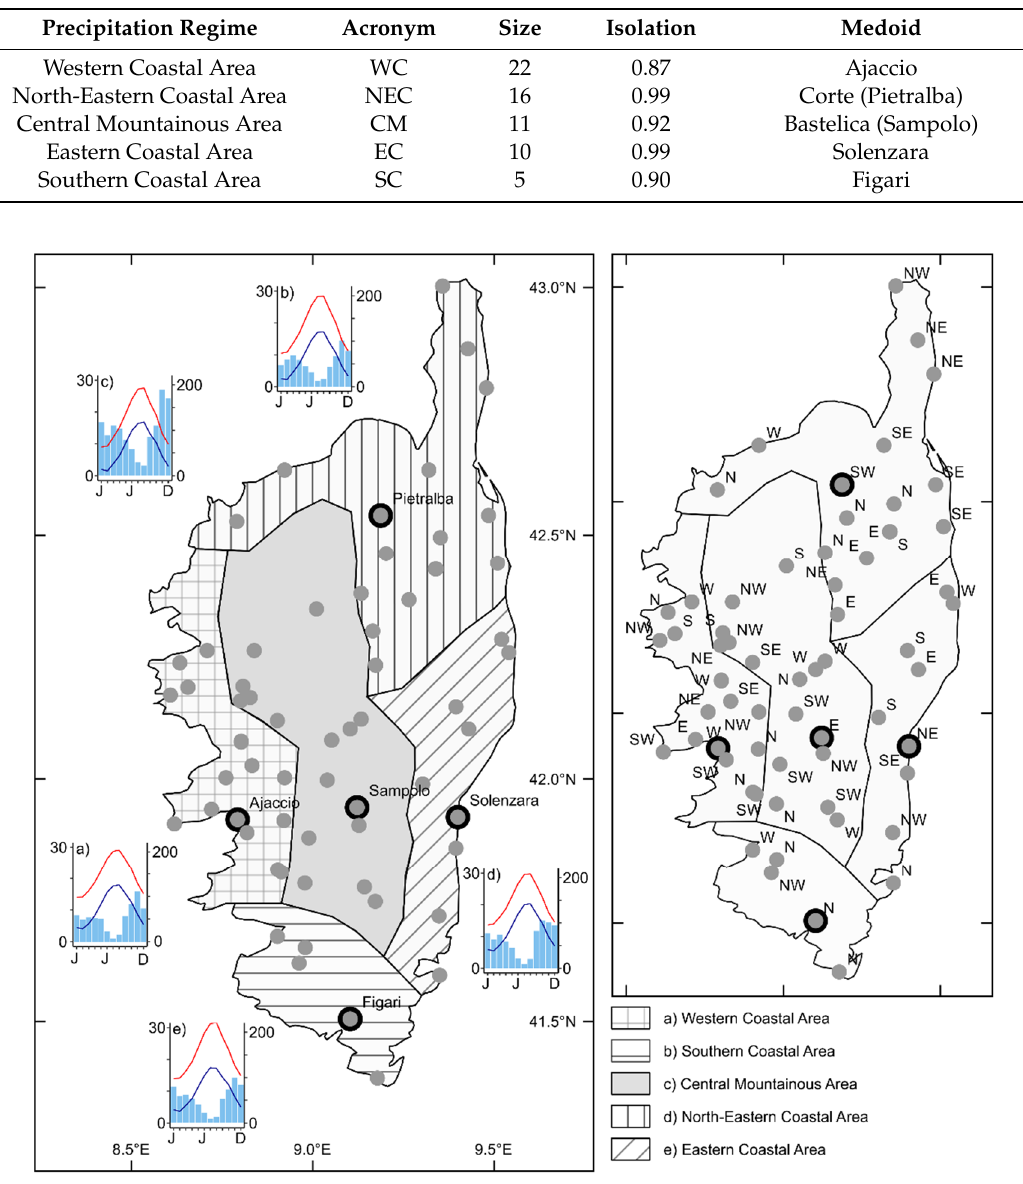
Figure 2. Spatial distribution of the location of the observational data on Corsica, the medoids of the cluster analysis being highlighted by circles in bold; (left) representative climate diagrams of the respective precipitation regime based on measured values from 1980 to 2018: average minimum (blue line) and maximum (red line) monthly temperatures as well as average monthly precipitation totals (blue bars); (right) topographical exposition of the respective weather station.